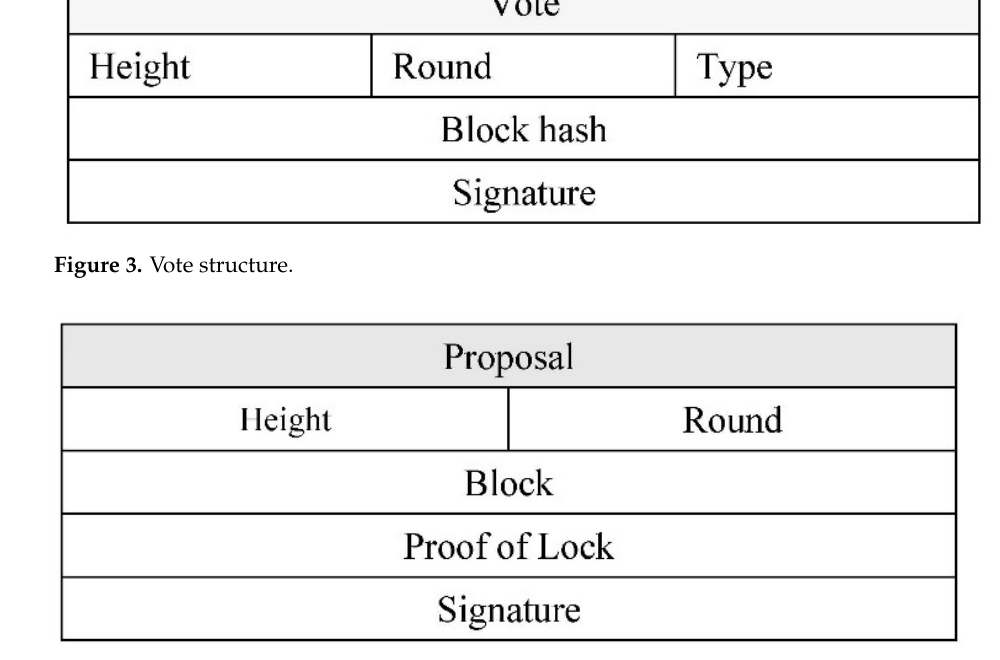
Figure 4. Proposal Figure 4. Proposal structure.